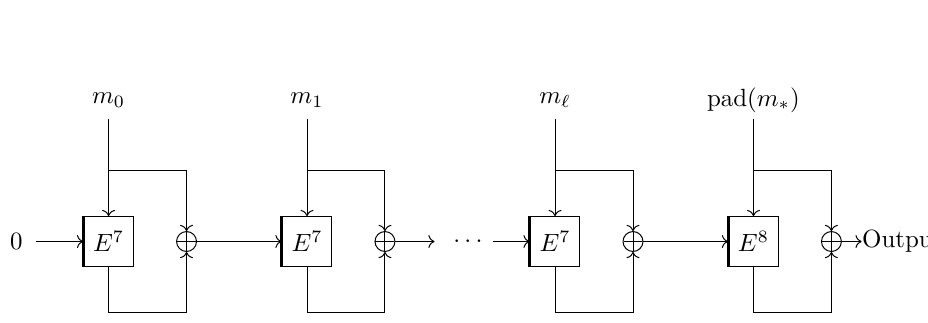
Figure 10: The hash function Saturnin -Hash, where 𝐸 𝑖 is Saturnin 16 with domain separator 𝑖 . A thick line represents the input of the key.